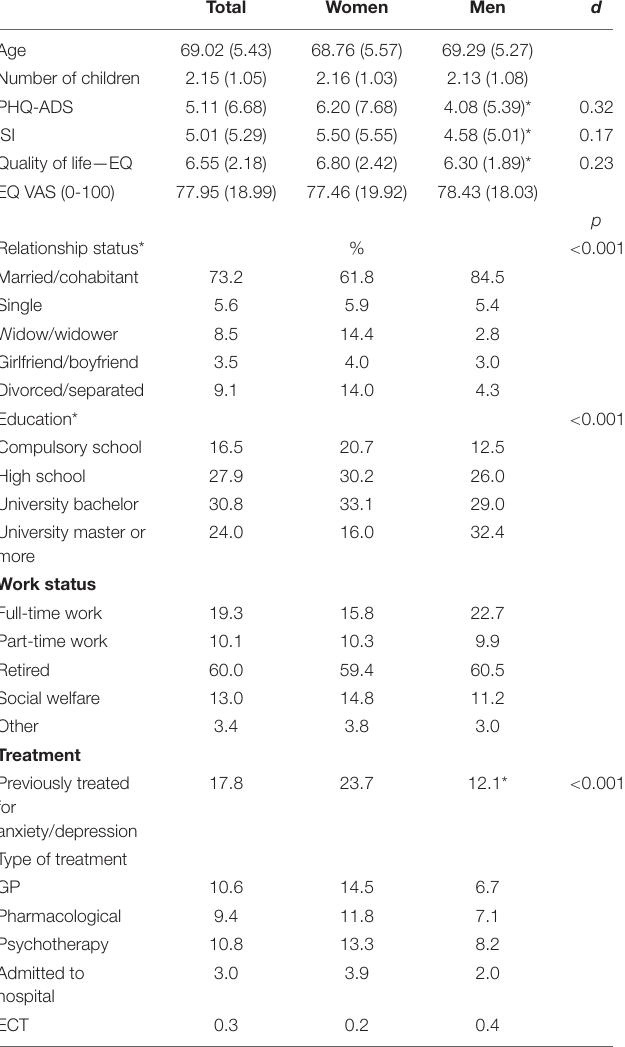
TABLE 1 | Demographic characteristics of the sample ( N =